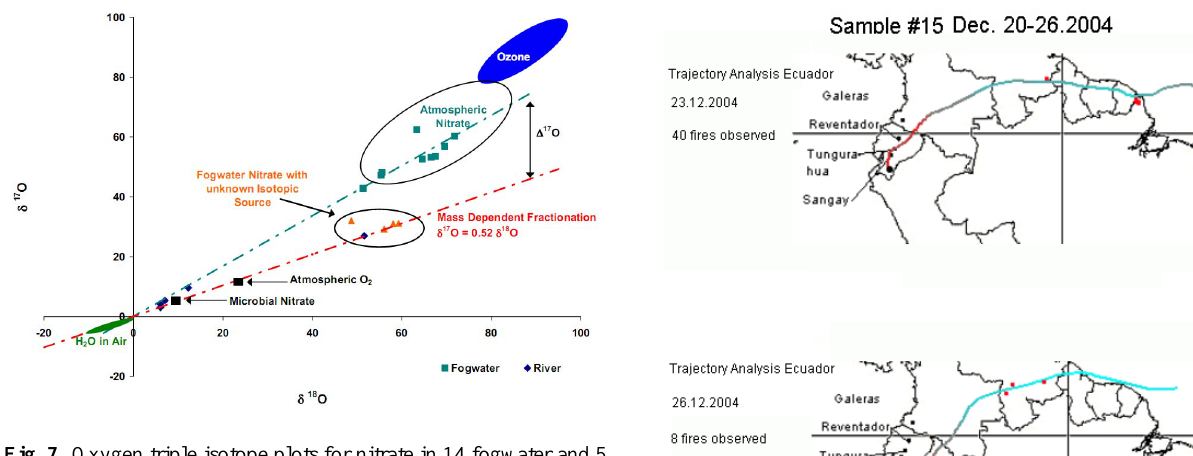
Figure 7: Fig. 7. Oxygen triple isotope plots for nitrate in 14 fogwater and 5 river water samples.